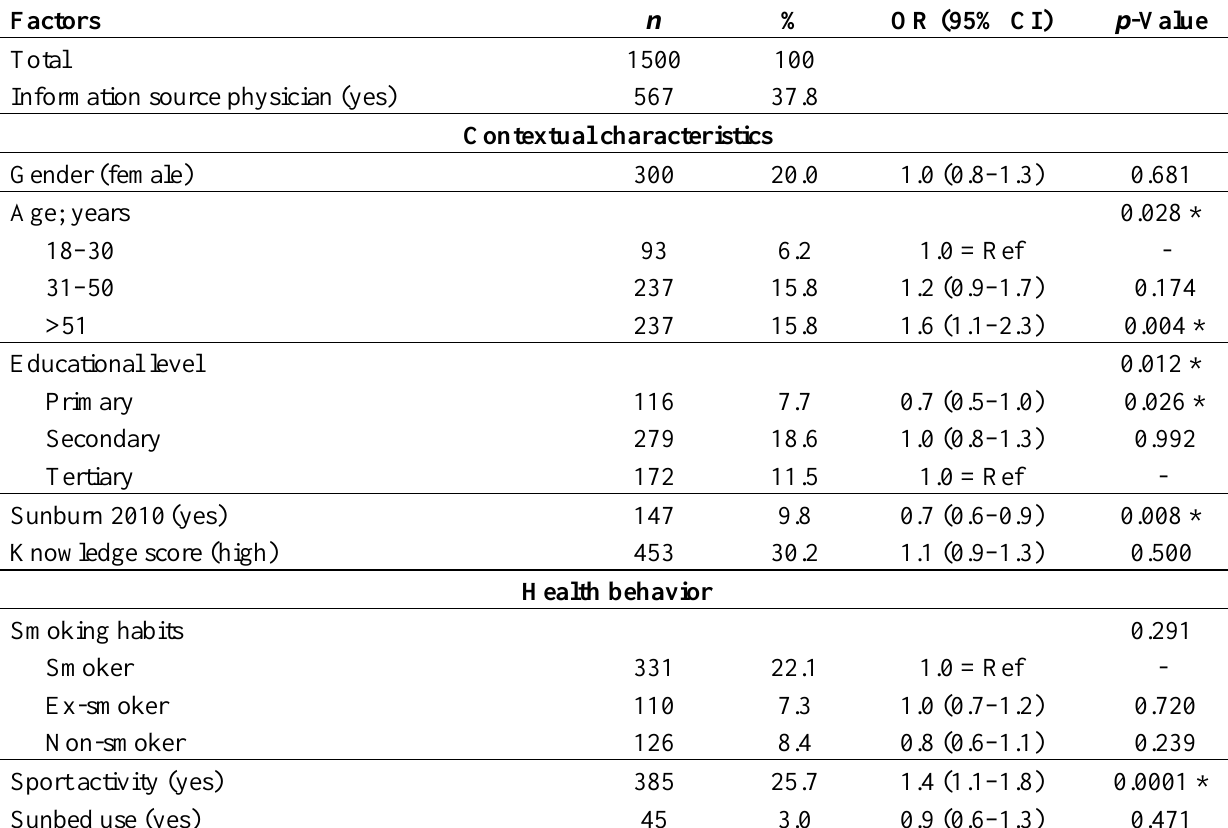
Table 4. Logistic regression analysis of factors affecting the prevalence of picking the information source physician. Odds ratio (OR), 95% confidence interval (95% CI), and overall factor-specific p -values are